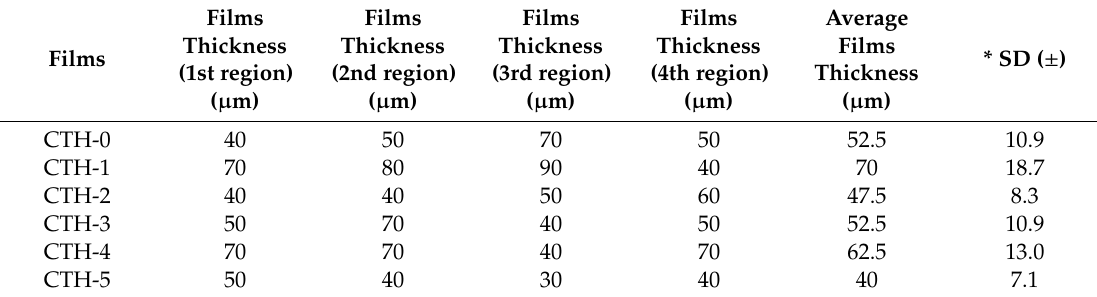
Table 1. Films thickness data of each film from different regions.